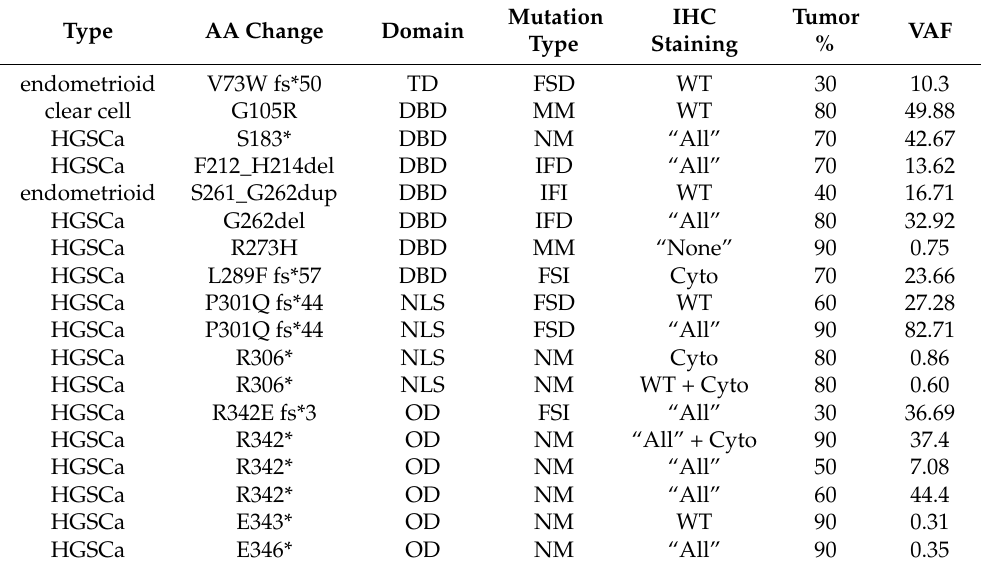
Table 2. Cases of IHC and TP53 mutation type mismatching (order by AA